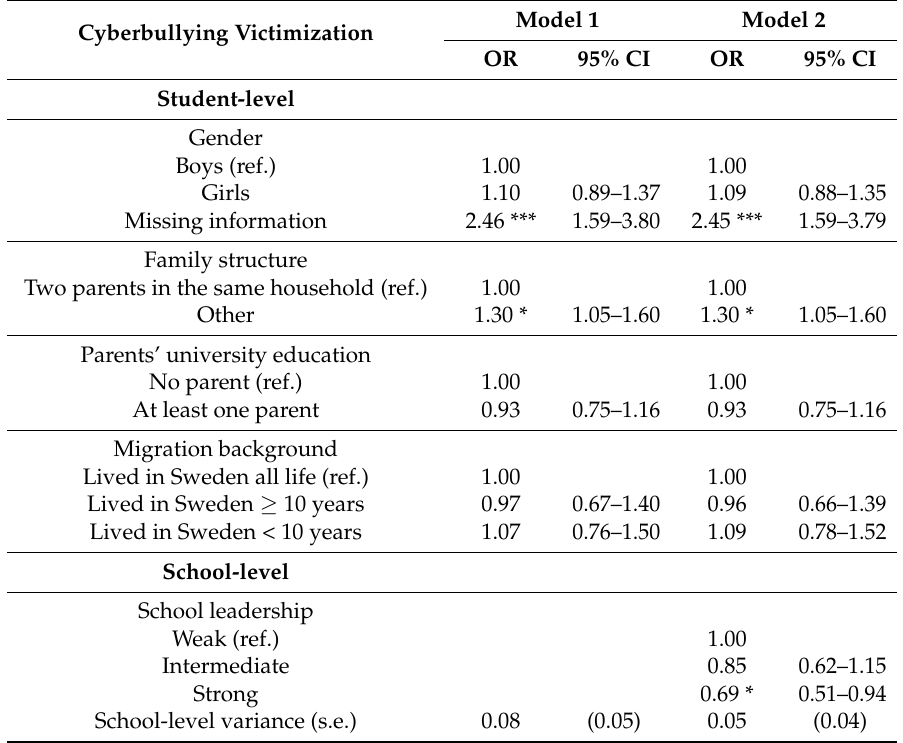
Table 3. Results from two-level binary logistic regression models of cyberbullying victimization. Odds ratios and 95% confidence intervals. n = 5657 students within 58